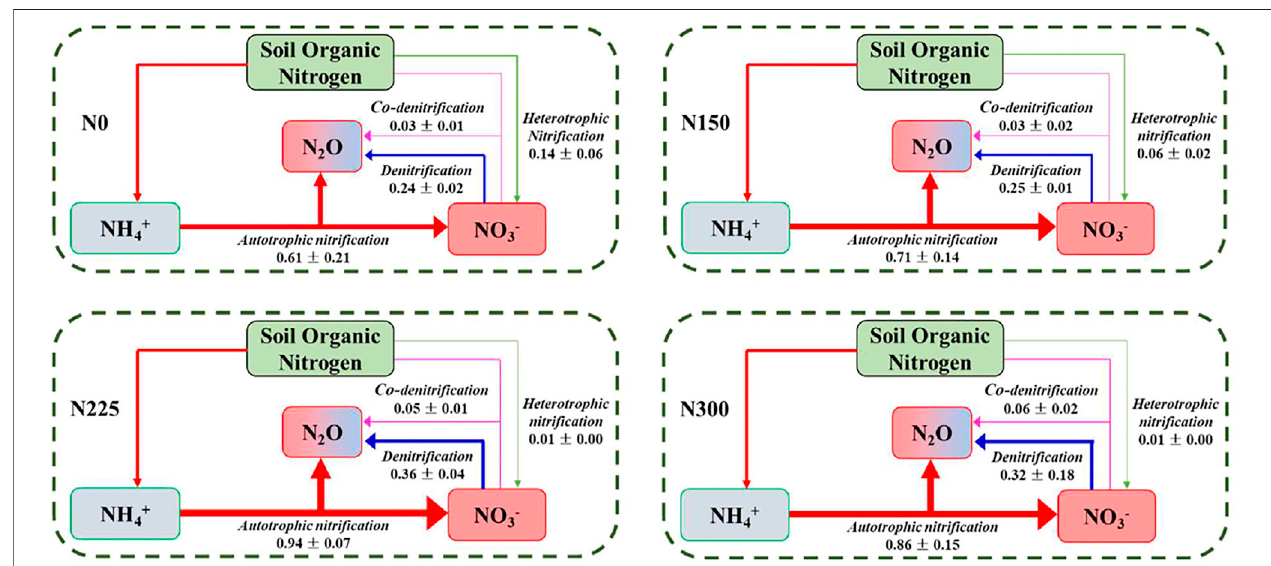
FIGURE4| N 2 Oproductionratesfromautotrophicnitri fi cation,heterotrophicnitri fi cation,denitri fi cation,andco-denitri fi cationinthesoilofthestudylawn.Dataare the mean ± SE (nmol N g − 1 dry soil h − 1 ) and the thickness of the arrow indicates the importance of each microbial process. N0: 0 kg N hm − 2 a − 1 ;